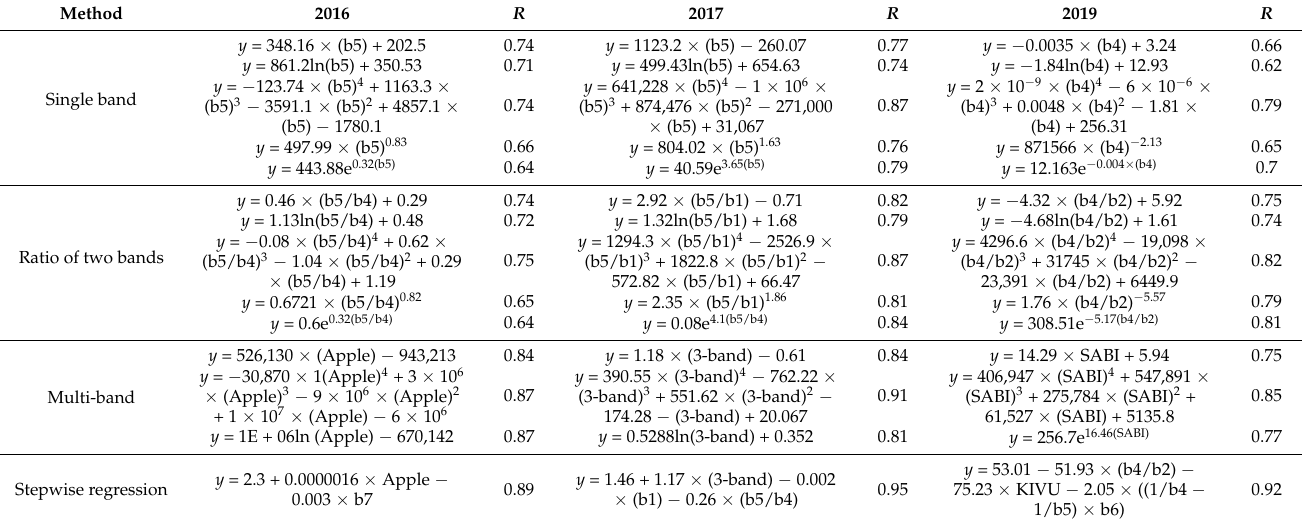
Table 4. Comparison of correlation, exponential, logarithmic, polynomial, and power function models regarding best parameters in each year, and stepwise regression model. The correlation between the simulated value from the stepwise regression model and the measured value from samples is the highest.